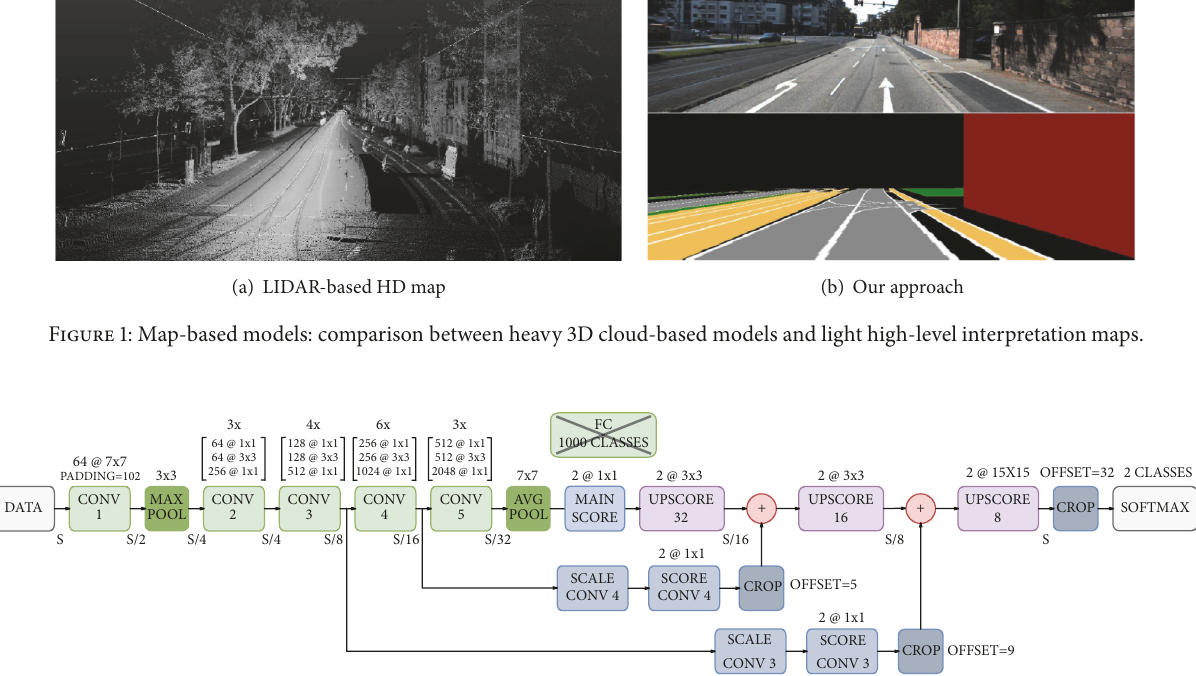
Figure 2: High-level schematic of the CNN-based road detector, implementing the FCN-8s architecture [7] on a ResNet-50.